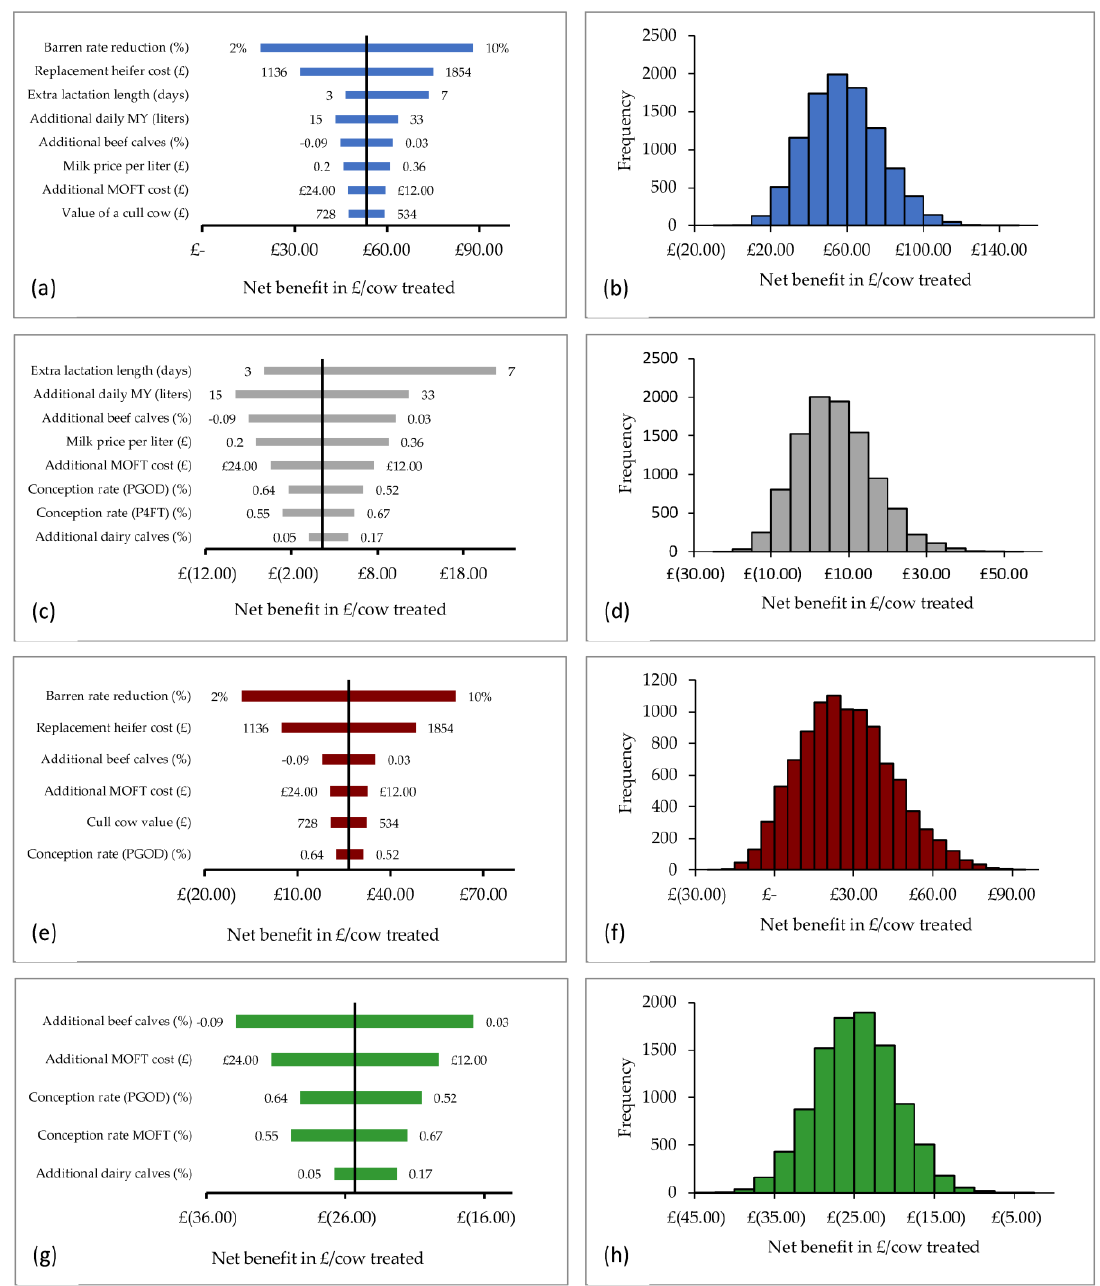
3333333 Figure 3. Sensitivity analysis and Monte Carlo simulation showing the influence of input variable uncertainties on the net benefit value in pounds sterling per cow treated; ( a , b ) herds with a fixed dry-off date and a reduced barren rate; ( c , d ) herds with a fixed dry-off date but no improvement in barren rate; ( e , f ) herds with a variable dry-off date and a reduced barren rate; ( g , h ) herds with a variable dry-off but no improvement in barren rate. X-axis values within brackets represent negative values.